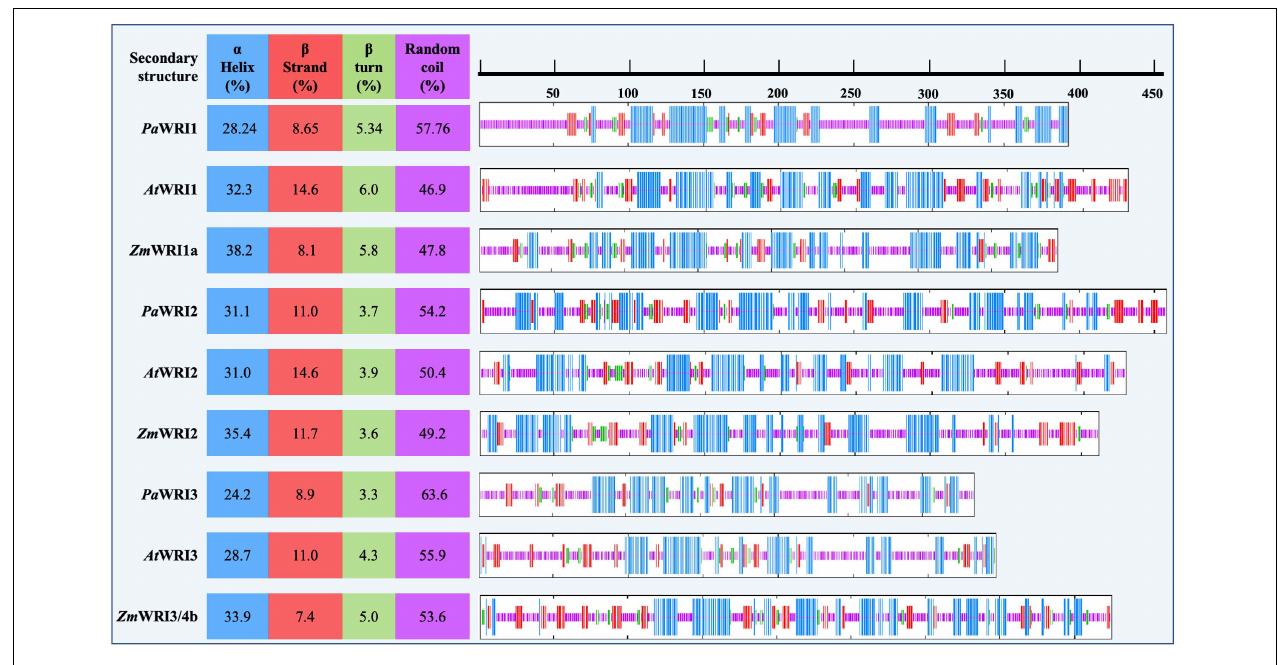
FIGURE 2 | Proportion of the predicted secondary structures in WRI homologs. Position of each of the secondary structures α helix (blue), β strand (red), β turn (green), and random coil (pink) among all the WRI1 homologs are schematically represented on the right. The color-coded regions represent the position of the corresponding secondary structures. Proportion of each of the secondary structures is represented as a percentage value on the left, for each homolog.